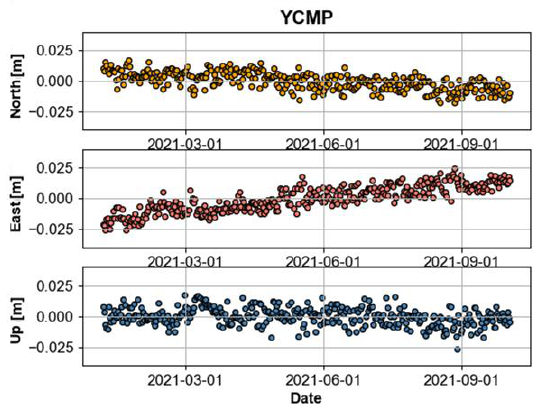
Figure A4. Time series GNSS Station in 2021.